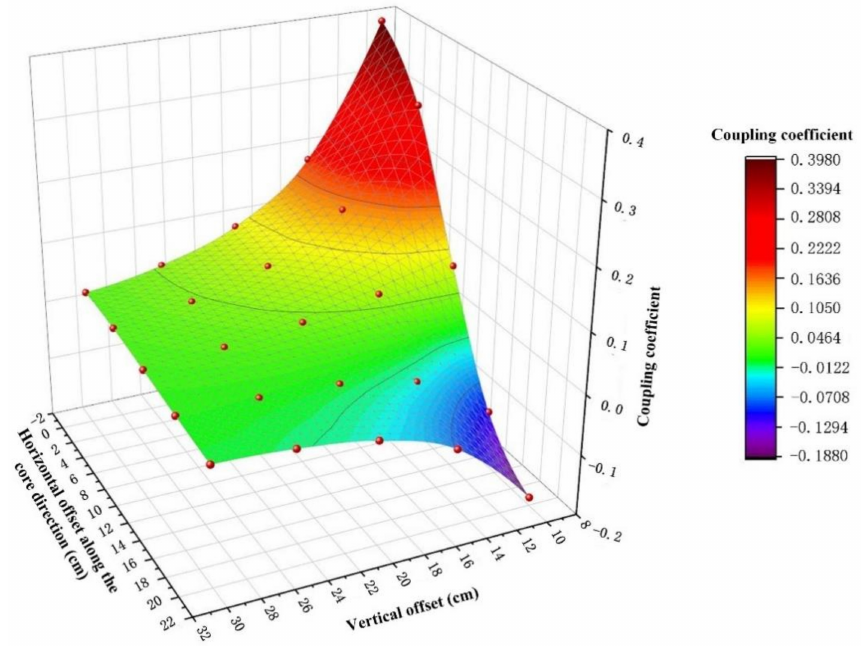
Figure 10. Relationship diagram of the coupling coefficient and ferrite direction misalignment in a transformer with rectangular structure.